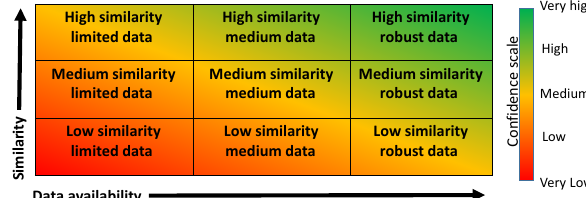
Figure 3. Matrix depicting the relationship between data availabil- ity, similarity to modelled fjords and confidence level. Adapted from IPCC 5th Assessment Report (Mastrandrea et al.,